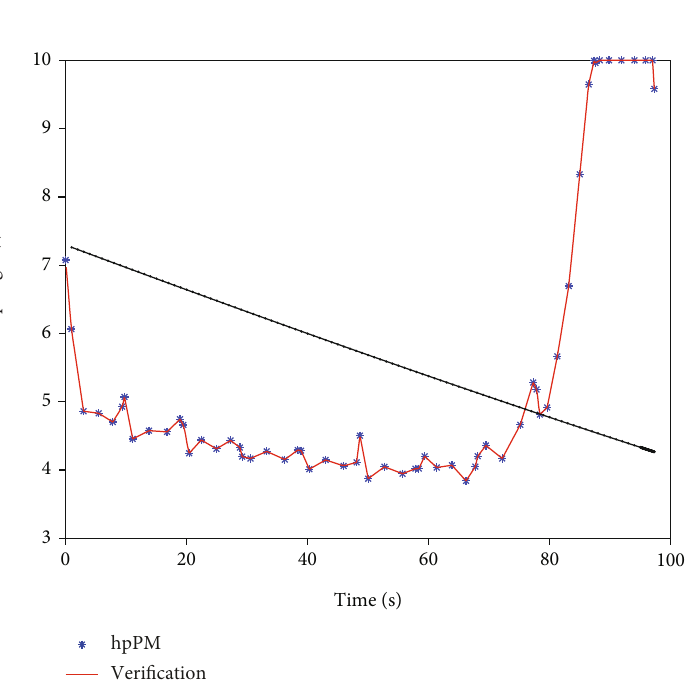
Figure 16: Attack angle.